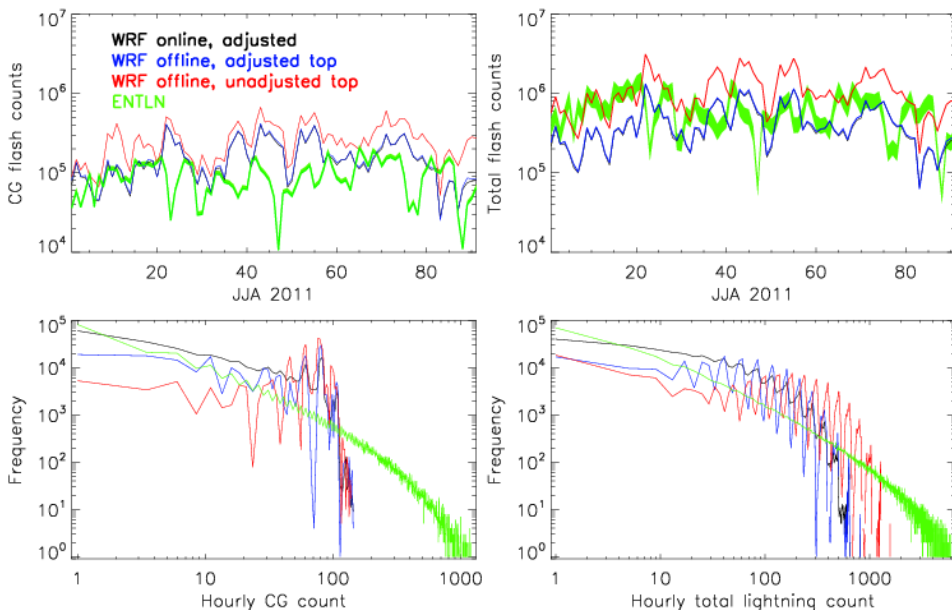
Fig. 9. Comparison of WRF predicted lightning flash counts generated online and offline with and without − 2km cloud-top height adjust- ments against ENTLN CG and total flash counts. Thicknesses of the ENTLN bands in the time series are computed using the minimum and maximum theoretical IC and CG detection efficiencies within the analysis domain. Noisiness of offline calculated distributions are associated with using hourly outputs only rather than accumulating flashes at every model time step. It should be noted that online (black) and offline (blue) WRF outputs with adjusted top appear coincident in the time series, but are evidently different from the frequency distribution.